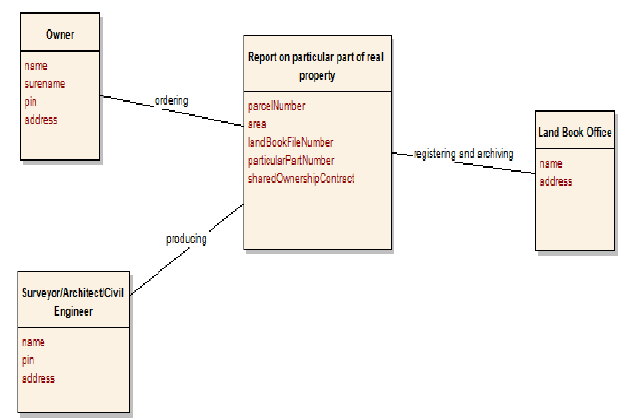
Figure 1. Presentation of creating a report on a particular part of a real